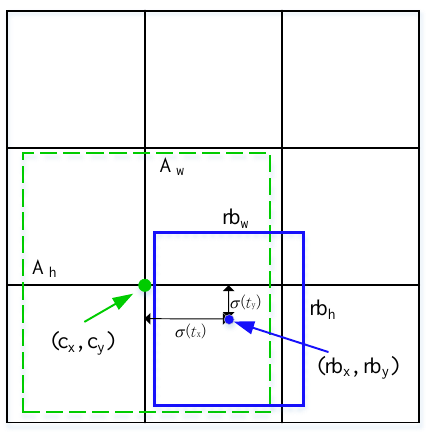
Figure 3. Bounding boxes for location